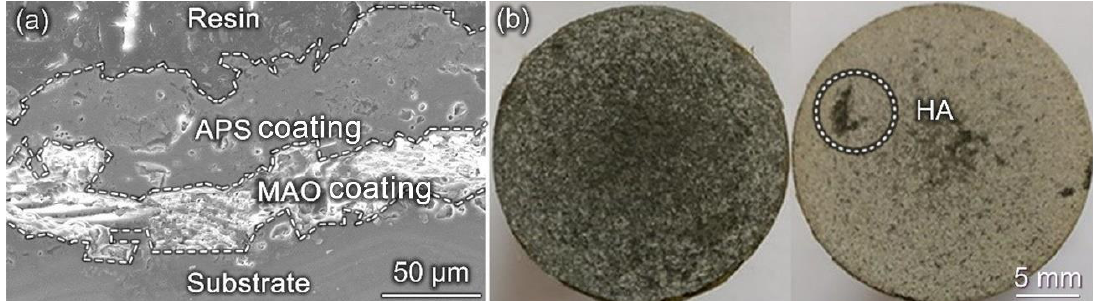
Figure 3. Cross-section morphology of MAO/APS coating: ( a ) macroscopic fracture morphology of sample; ( b ) macroscopic fracture morphology of MAO/APS coating.